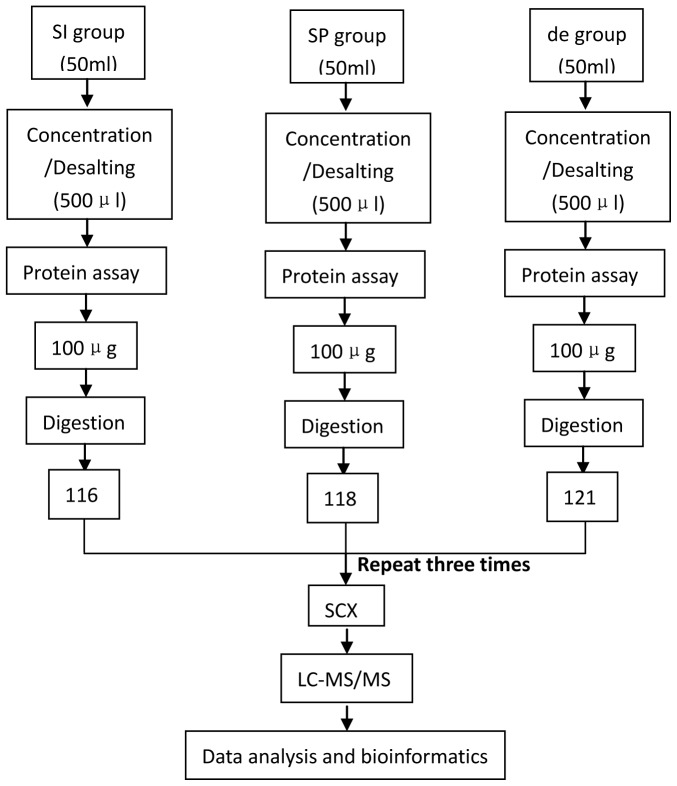
Schematic of the experimental design based on iTRAQ labeling combined with 2-D LC-MS/MS analysis of SI, SP, and de.SCX, strong cation exchange. SI: urine specimens from patients with SIRS. SP: urine specimens from sepsis patients, acquired within 24 h of admission to the ICU. de: urine specimens from sepsis patients, acquired within 48 h before death.